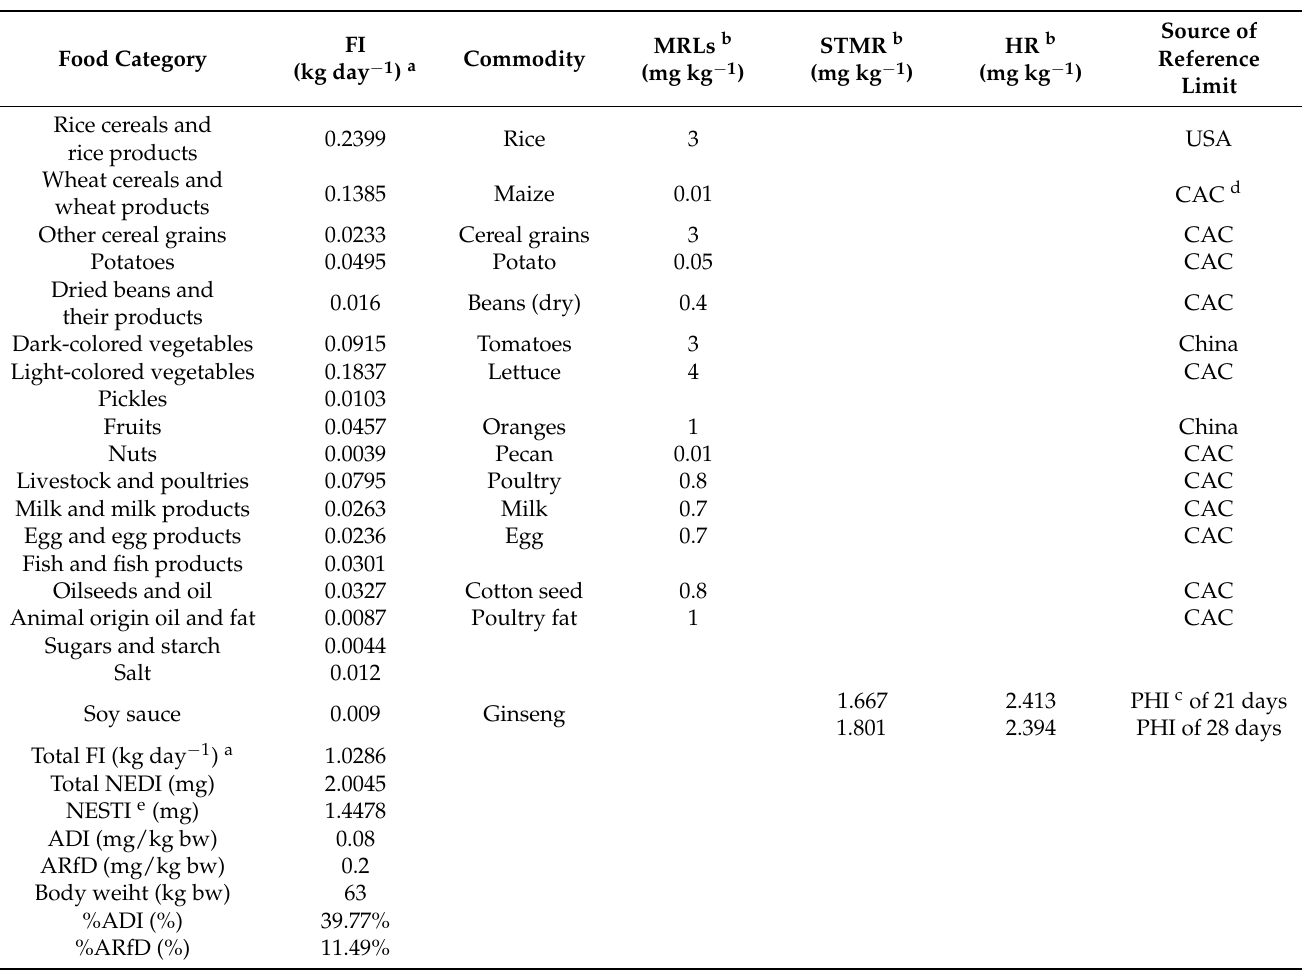
Table 3. The long-term and short-term dietary intake risk assessment of flupyradifurone based on the Chinese dietary